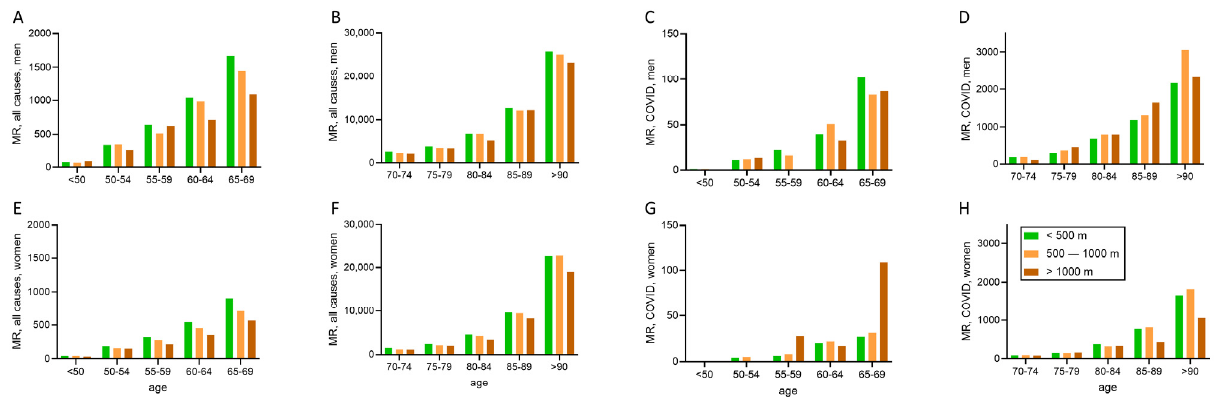
Figure 2. Altitude-dependent mortality rates (MR) of different age-groups of both sexes (( A – D